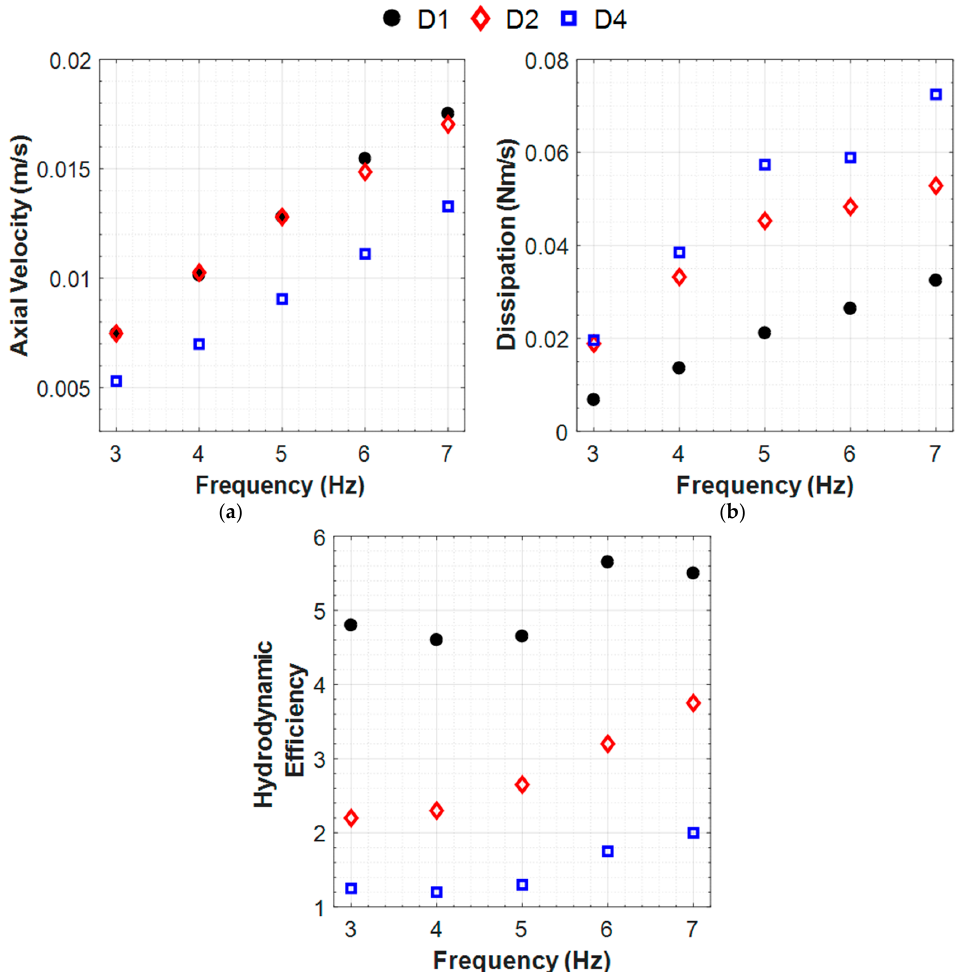
Figure 11. Axial velocity ( a ), energy dissipation ( b ) and hydrodynamic e ffi ciency ( c ) results for di ff erent two-flagellum configurations in 30,000 cSt silicone